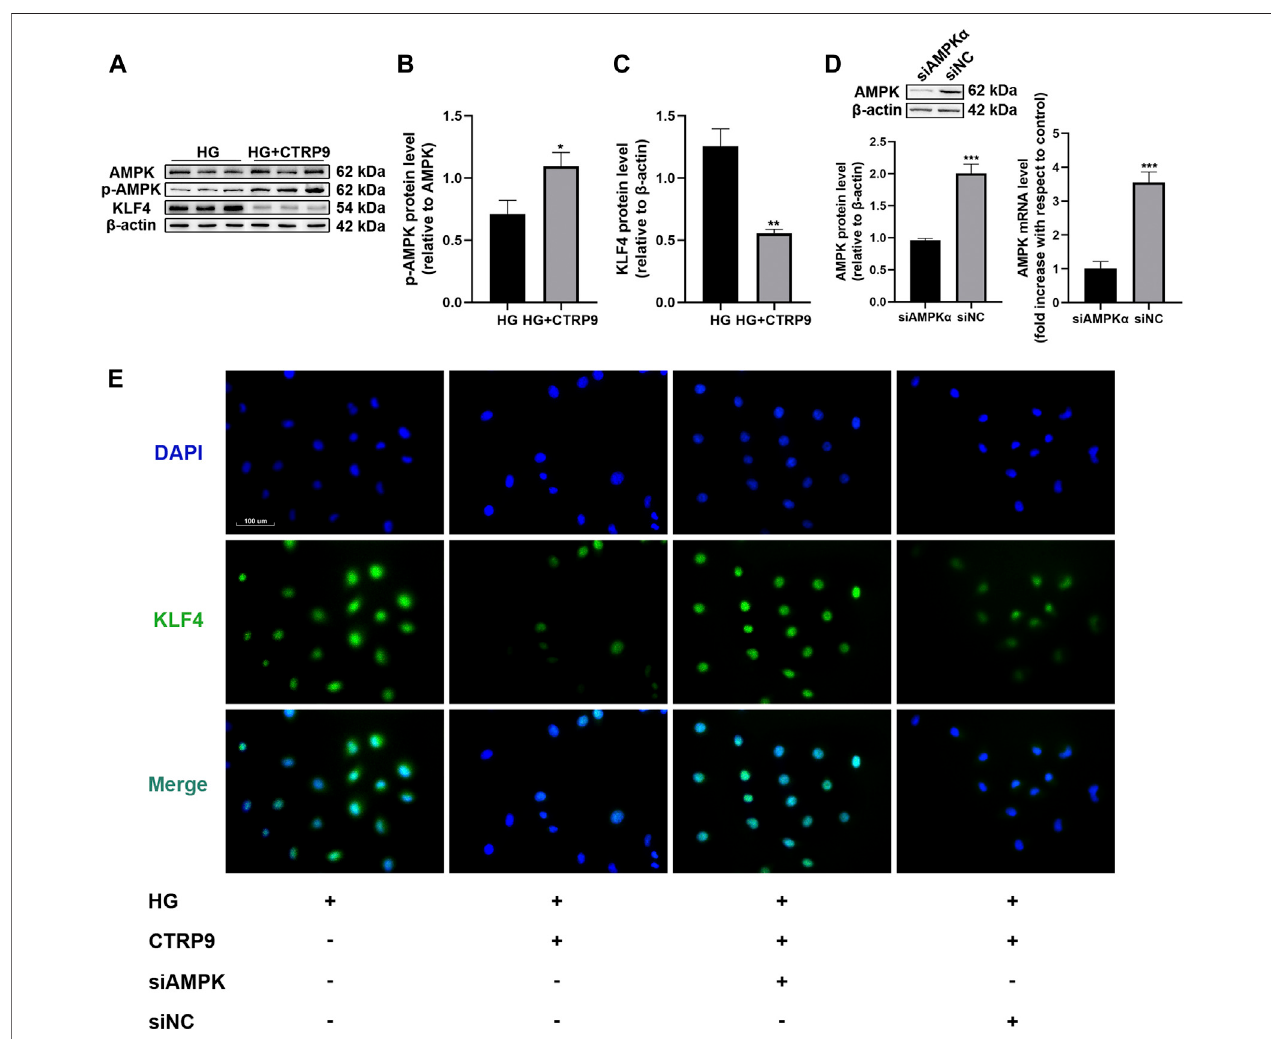
FIGURE 4 | CTRP9 treatment promotes the phosphorylation of AMPK and inhibits KLF4 protein expression. (A) AMPK, p-AMPK and KLF4 protein levels were determined by immunoblotting. (B – C) Results were normalized to controls, and histograms represent the relative intensity of KLF4 and p-AMPK. Values represent mean ± SEM ( n (cid:2) 3-4 per group). *p < 0.05, **p < 0.01, signi fi cantly different from HG. (D) AMPK α , as measured by immunoblotting, and qRT-PCR results of HUVECs after transfection with siNC or siAMPK α for 48 h. Values represent mean ± SEM ( n (cid:2) 3 – 4 per group). ***p < 0.001. (E) Intracellular KLF4 levels were measured by immuno fl uorescence staining. The images were taken at × 200magni fi cation and sections were stained with KLF4 (green) and DAPI (blue). A representative image from three separate experiments is illustrated.